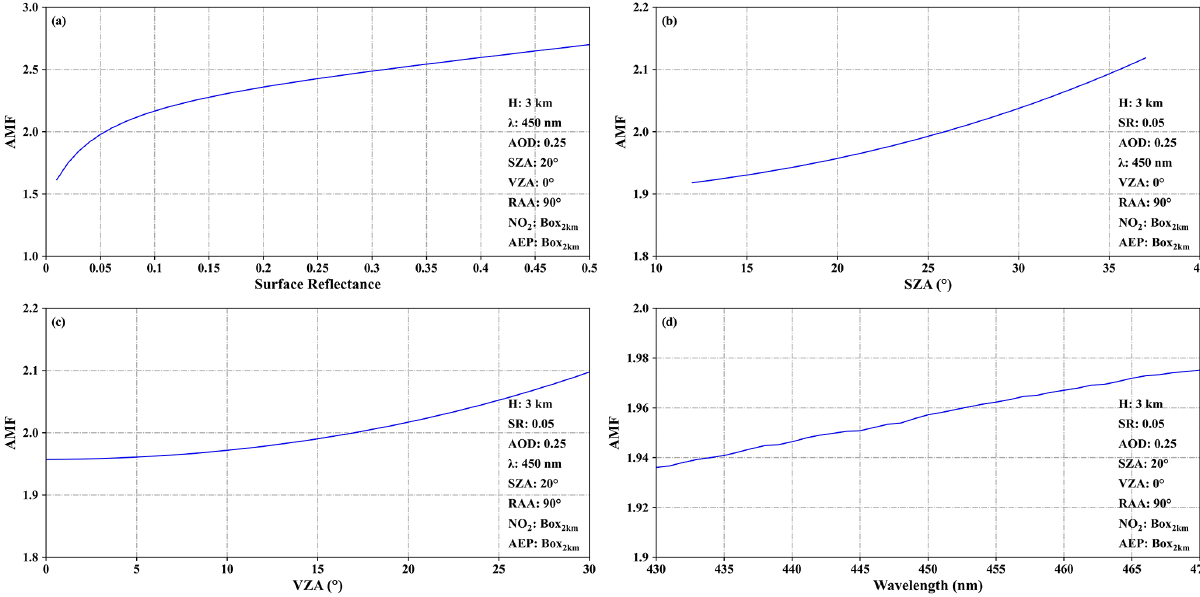
Figure 8. AMF dependence analysis results (a) on the surface reflectance; (b) on the SZAs; (c) on the VZAs; (d) on the wavelength.